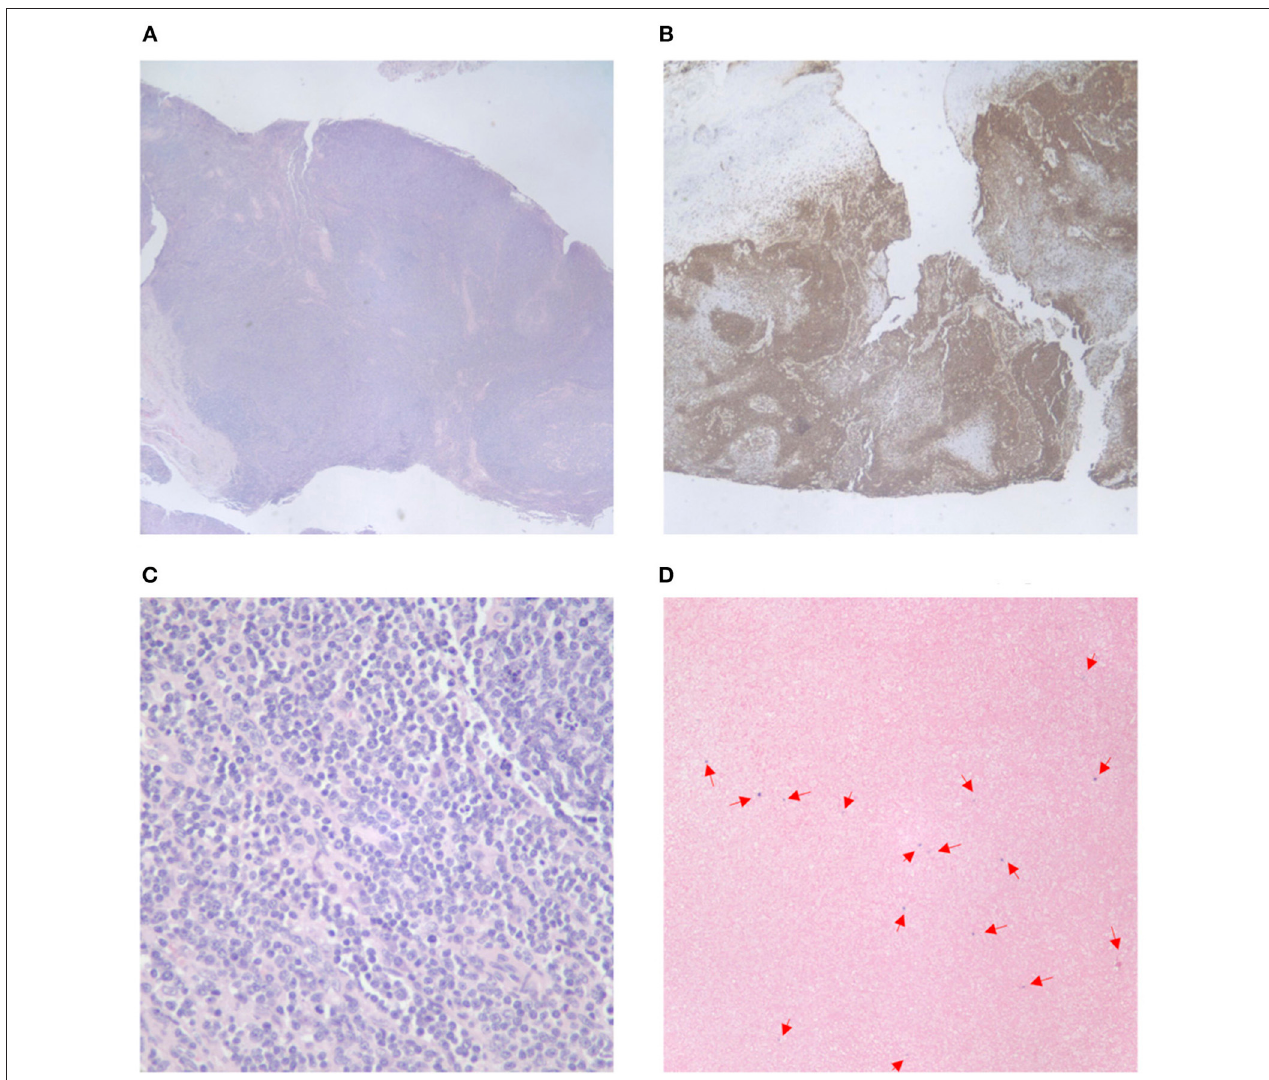
FIGURE 1 | Cervical lymph node pathology. (A) Effacement of lymph node architecture, with vague nodular growth pattern. (B) Increased CD20 tissue staining in the lymph node tissue. (C) Increased CD20 tissue staining in the lymph node tissue (40x magnification). (D) EBV in situ hybridization—positive staining for EBV in a small amount of scattered lymphoid